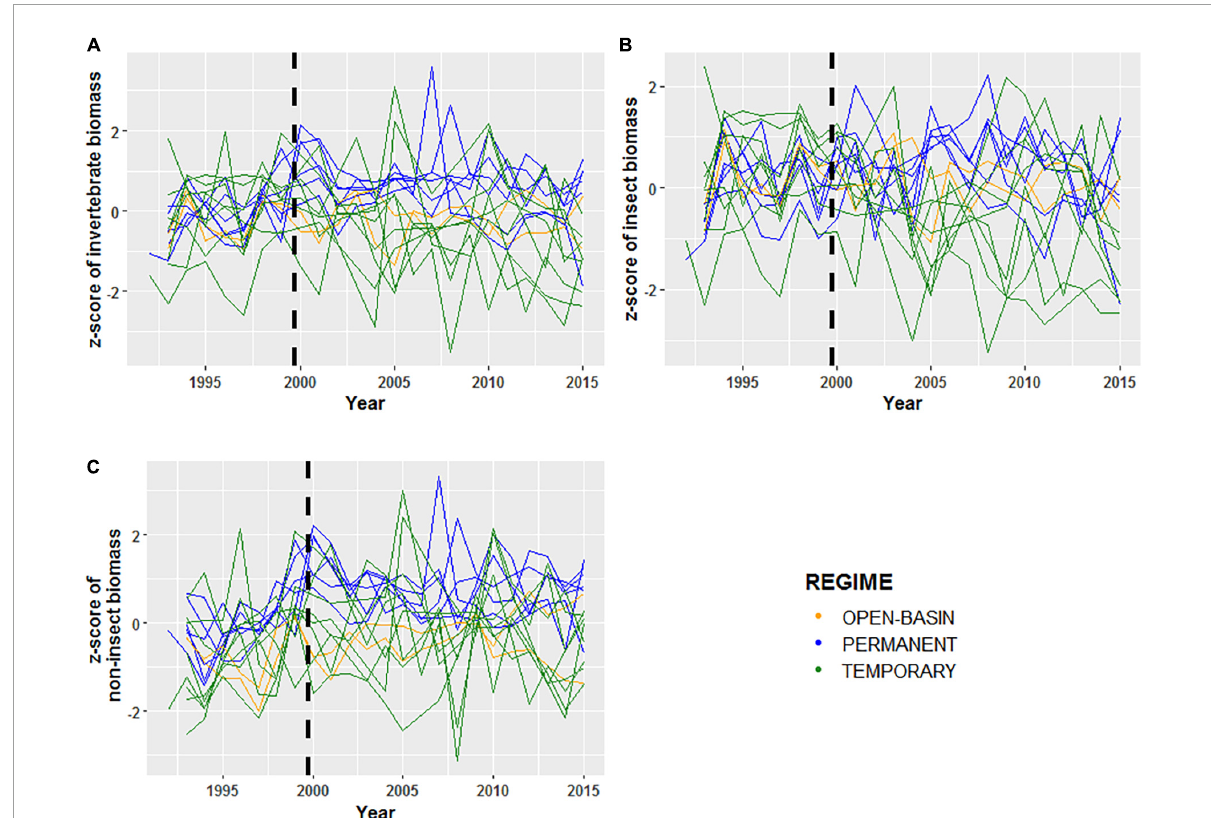
FIGURE5 Normalized z-scores of log transformed mean annual (A) invertebrate biomass (g), (B) insect biomass (g), and (C) and non-insect biomass (g) for 16 Cottonwood Lake study area wetlands sampled from 1992 to 2015. For each plot, green lines represent temporarily ponded wetlands (T wetlands), blue lines represent permanently ponded wetlands with closed basins (P wetlands), and orange lines represent permanently ponded wetlands with open basins (OB wetland). The black dashed lines indicate the transition for the “filling period” (1992–2000) and the “post-filling period”